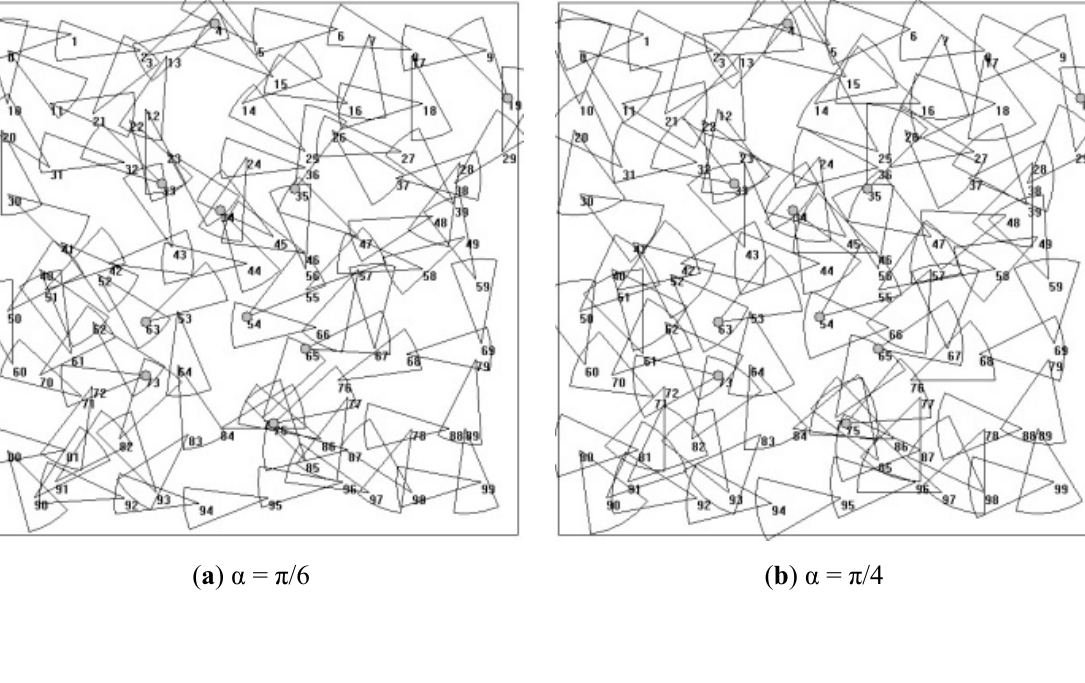
Figure 8. Example of simulated